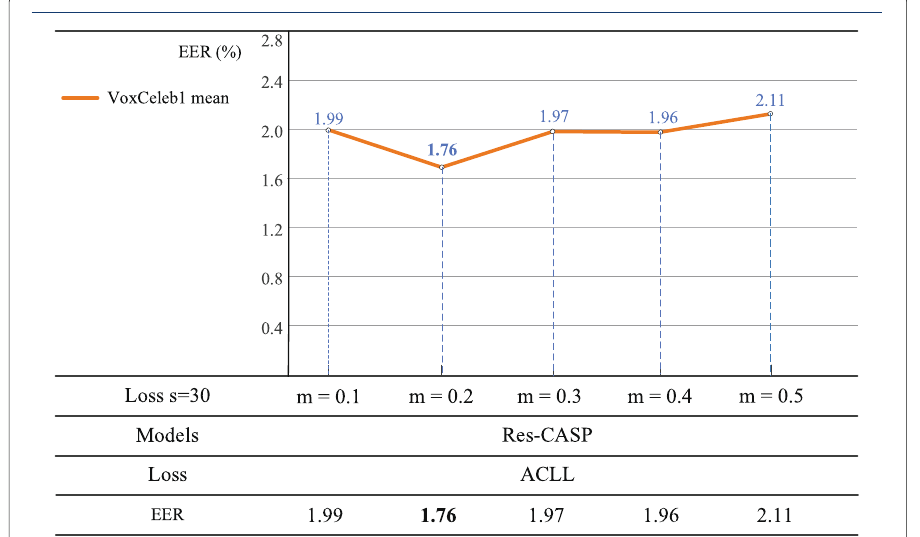
Fig. 5 The average EER of text-independent speaker recognition at s = 30, m = 0.1 ∼